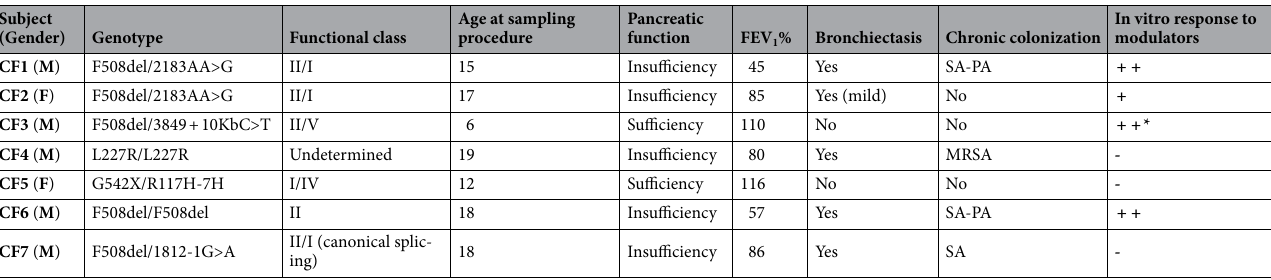
Table 1. Patients’ clinical information and in vitro response to modulators. CF1 and CF2 subjects share the same genotype but are unrelated. Pathogenic variants are indicated with their legacy names. Gender: M (male) F (female); Chronic colonization: SA ( Staphylococcus aureus ), MRSA (methicillin resistant Staphylococcus aureus ), SA-PA ( Staphylococcus aureus and Pseudomonas aeruginosa ). Last column describes in vitro nasospheroid response to VX-770 + VX-809 and/or VX-770 + VX-661 assessing FR and AUC analysis in IFRA after live-cell imaging assay (t = 60 min). Responses were categorized according to the statistical differences found between FSK and VX treatment: + + notable response = observed in both, FR and AUC values; + moderate response = significant differences in FR or AUC values; − no response = no significant differences. * Only responder to VX-770 +